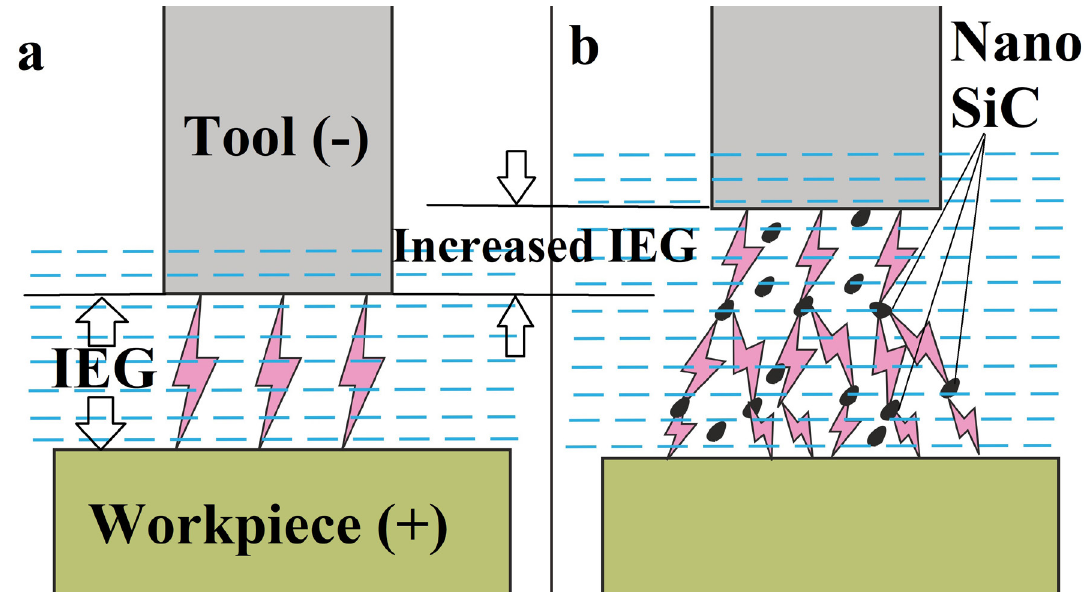
Figure 1. (a) Conventional EDM (b) Nano SiC mixed